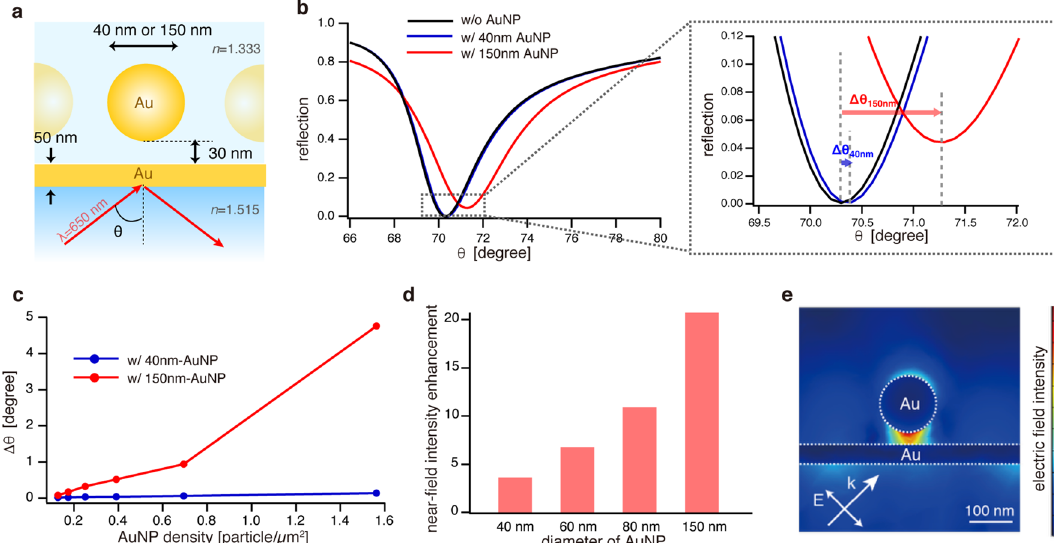
Figure 3. ( a ) Simulation model of nanoparticle-enhanced SPR. ( b ) Angle-resolved reflection spectra (SPR curves) with and without AuNPs of 40 nm and 150 nm diameters. ( c ) SPR angular shift as a function of AuNP density for AuNPs of 40 nm and 150 nm diameters. ( d ) Diameter-dependent near-field intensity enhancement at the gap between an AuNP and the Au chip substrate. ( e ) Electric field distribution in the vicinity of an AuNP of 150 nm